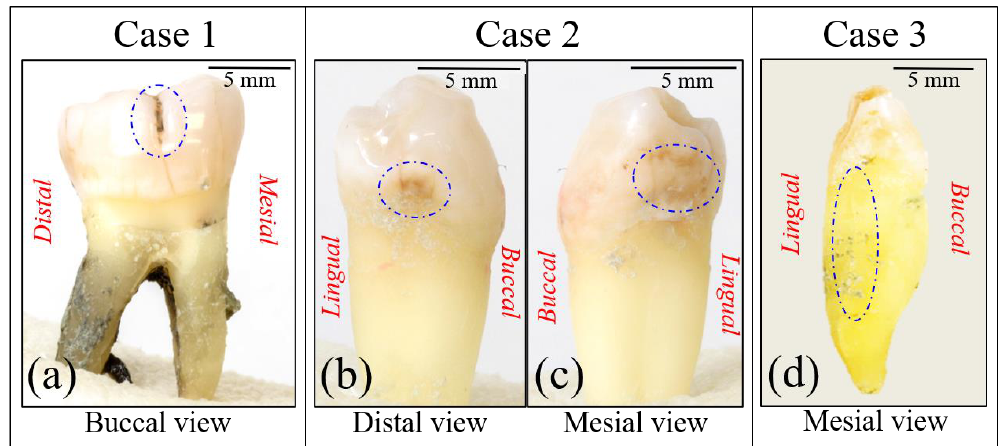
Figure 1. Photographs taken with a standard digital camera of the three selected cases of explanted teeth examined in this paper, referred to as Cases 1, 2, and 3 (in ( a ), ( b , c ), and ( d ), respectively). Dotted circles indicate cavities or fracture.